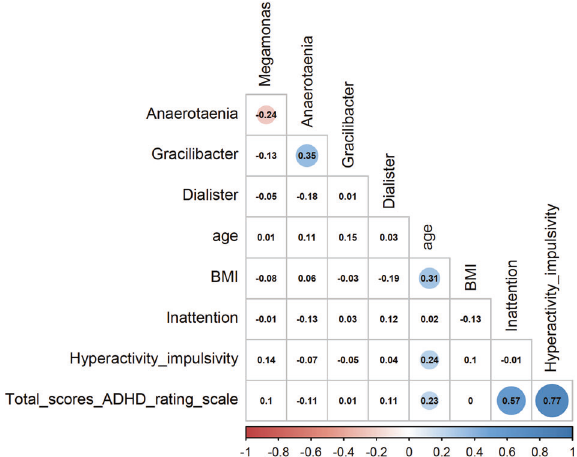
Fig. 2 Spearman correlation between the relative abundance of four bacterial genera ( Anaerotaenia, Dialister, Gracilibacter, and Megamonas) and age, BMI, and ADHD rating scale scores. Colored correlations are statistically signi fi cant ( P -value < 0.05), with positive and negative correlations in blue and red, respectively. Inattention: score of the inattention subscale of the ADHD rating scale; hyperactivity_impulsivity: score of the hyperactive/impulsivity sub- scale of the ADHD rating scale; total: total scores of the ADHD rating scale.